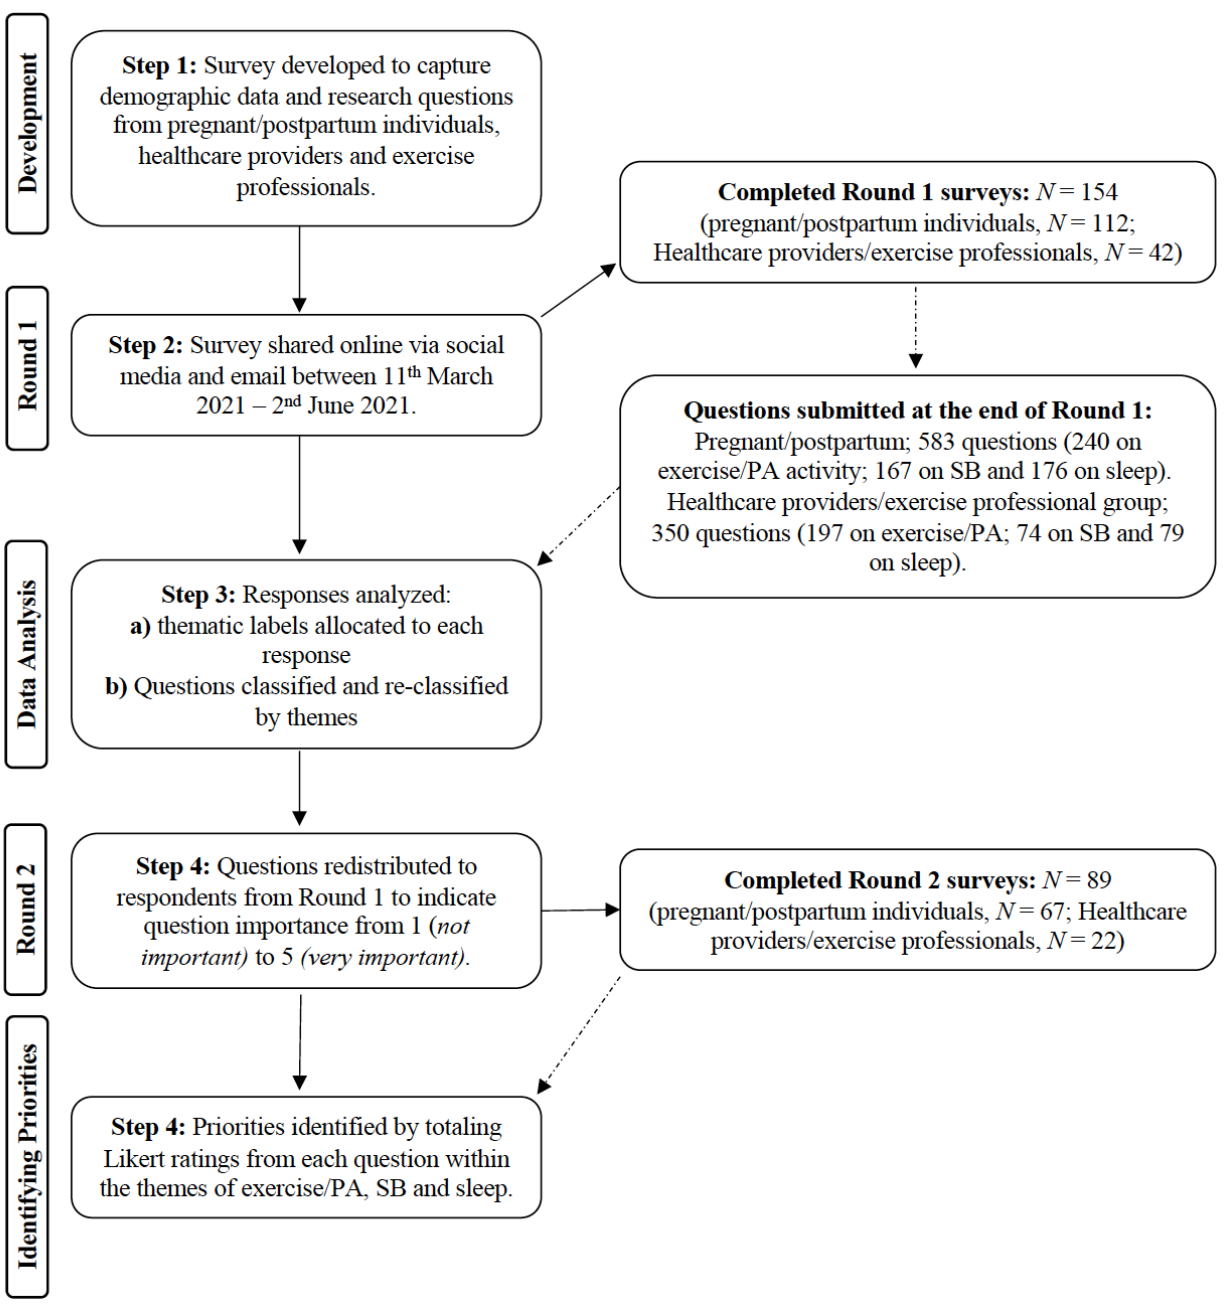
Figure 1. Modified Delphi approach used. PA, physical activity; SB, sedentary behavior.